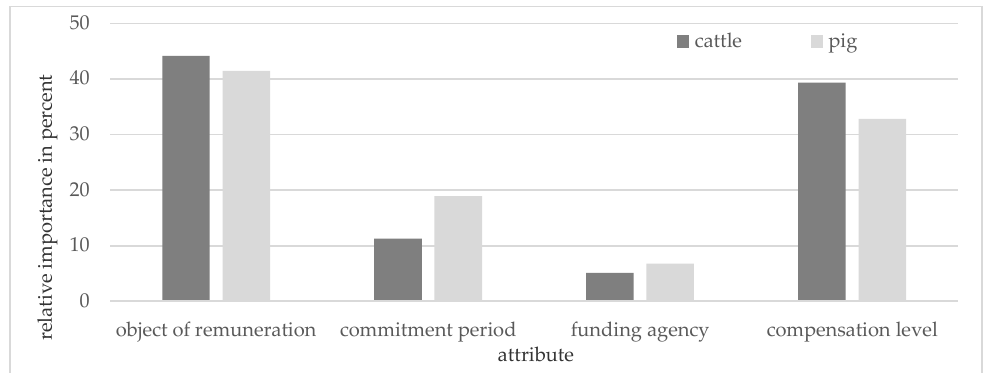
Figure 2. Relative importance of the evaluated farm animal welfare program attributes separately for cattle farmers and for pig farmers.